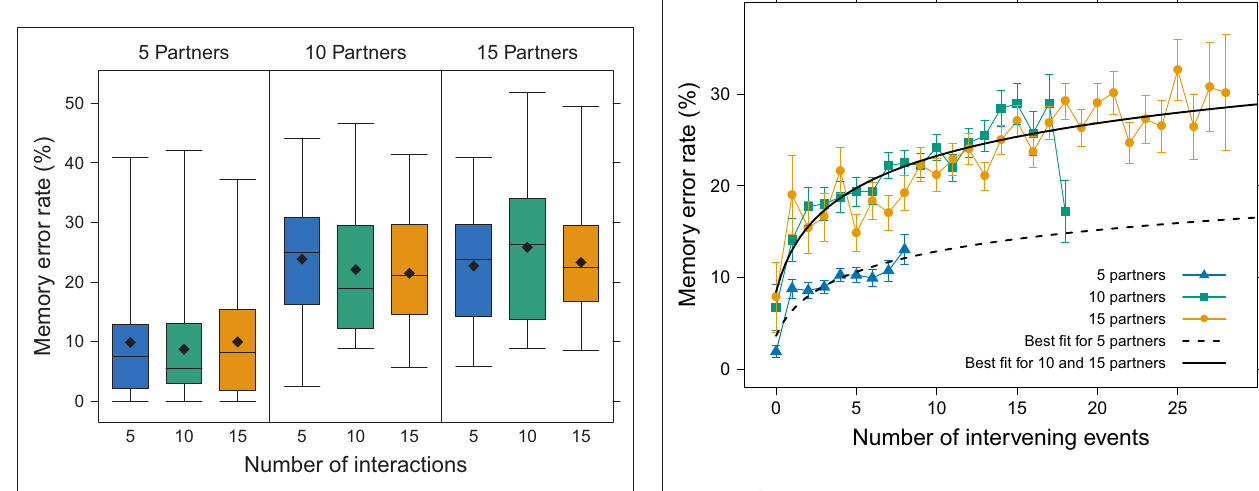
FIguRE 3 | Interference effects on memory accuracy. The mean ( ± SEM) error rate increased with more intervening interactions across all three group sizes (collapsing across the number of interactions per partner), with the effect more pronounced in group sizes of 10 or 15. The smooth lines represent the least-squares best-fit Wickelgren’s (1974) power function of memory to either the 5-partner data or combined 10- and 15-partner data (for both lines, R 2 =